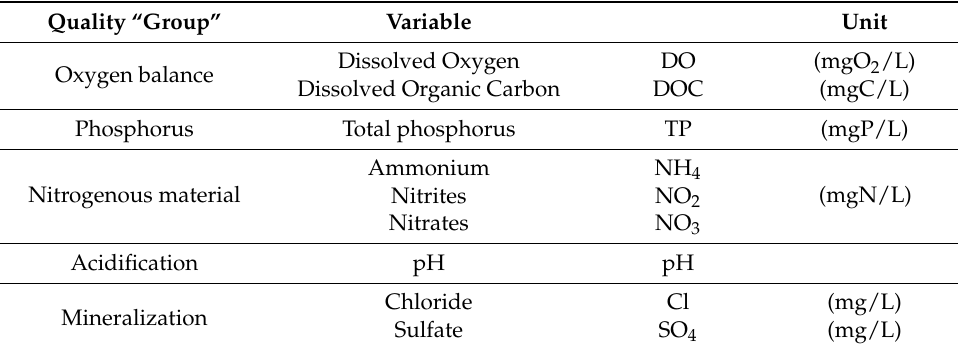
Table 1. Physico-chemical variables